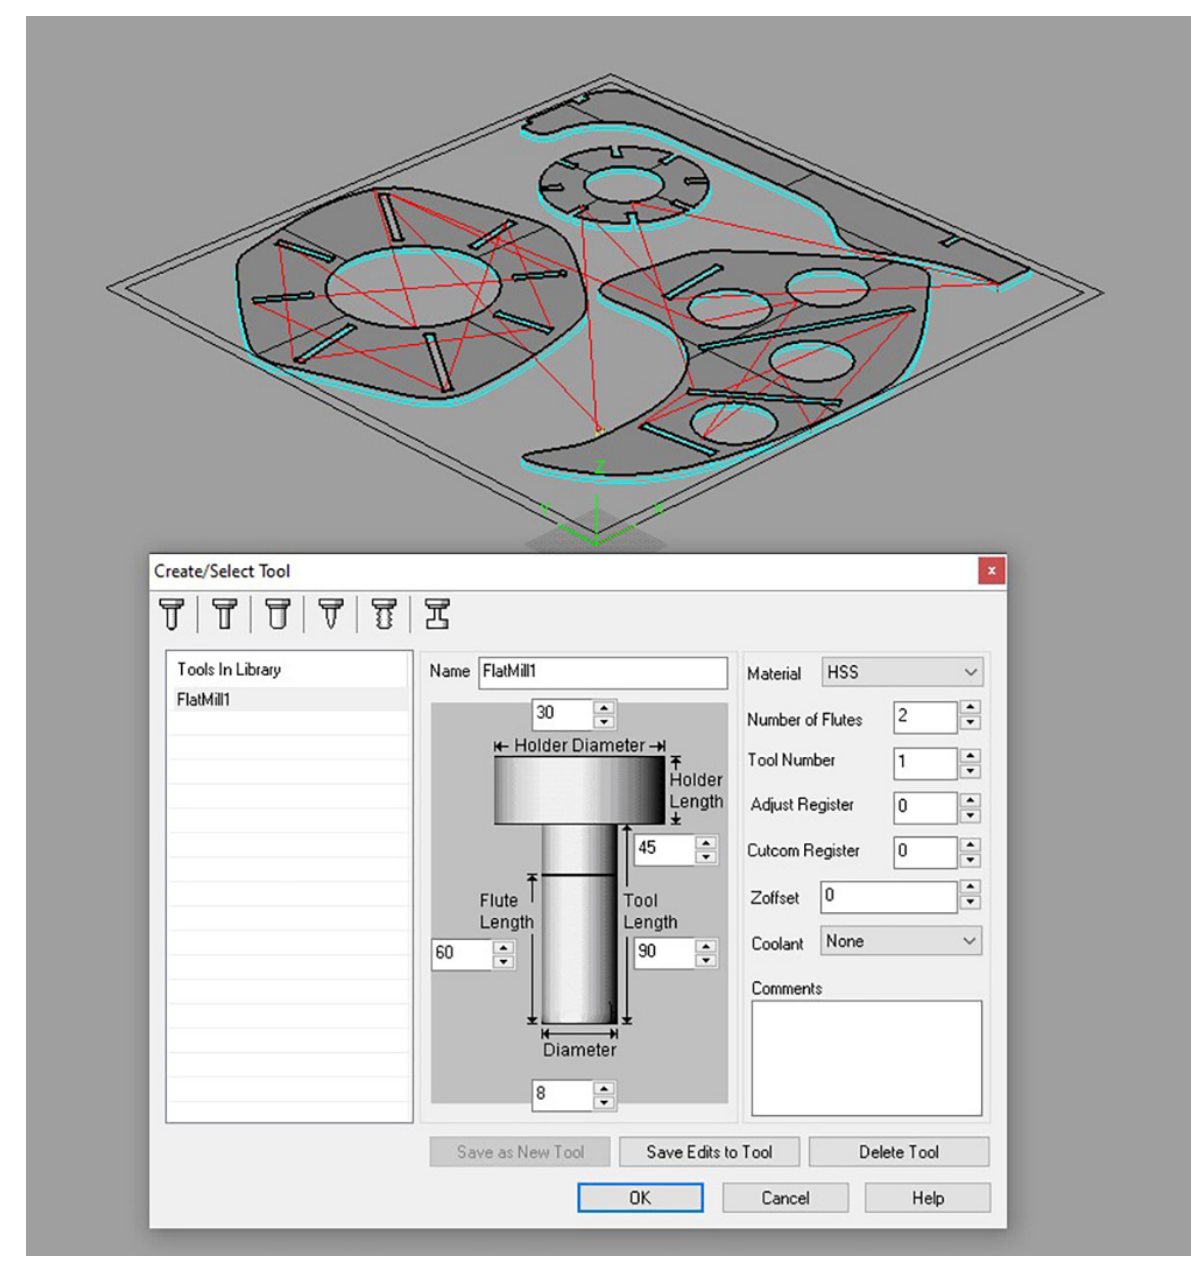
Figure 9. Tool path generation.